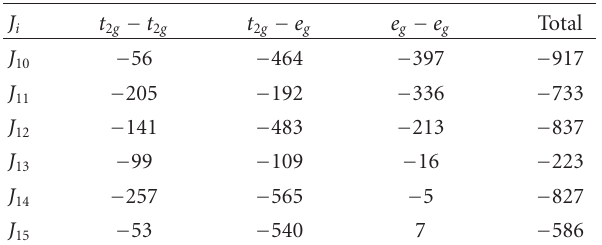
Table 5: Total and partial interribbon exchange interaction param- eters are shown [211]. The values are given in kelvin. The spatial representation of all these exchanges is schematically presented in Figure 20.